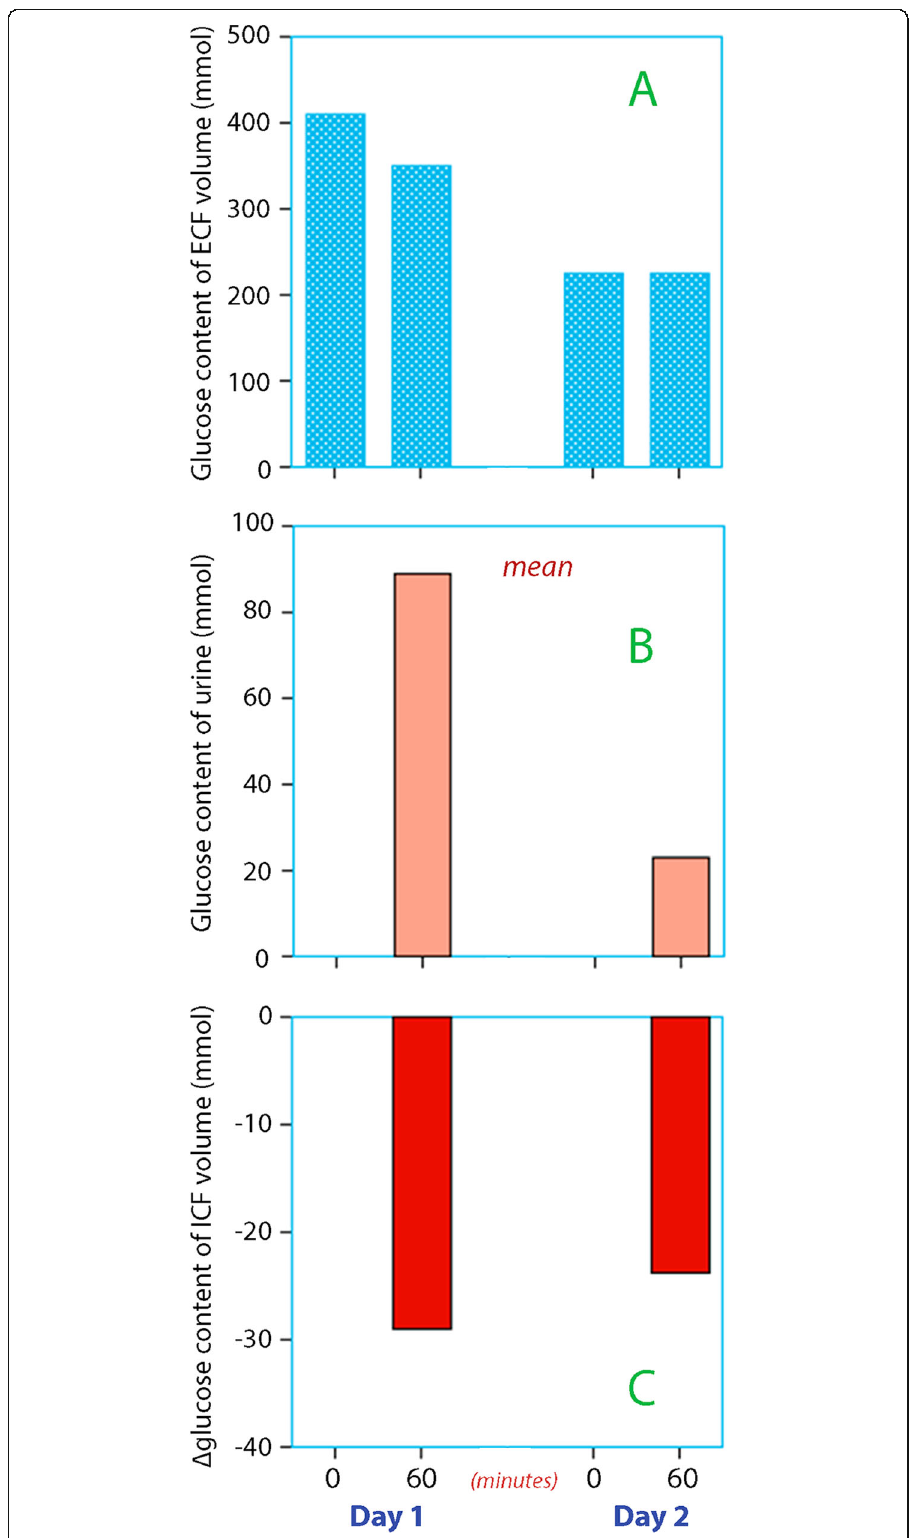
Fig. 3 (See legend on next